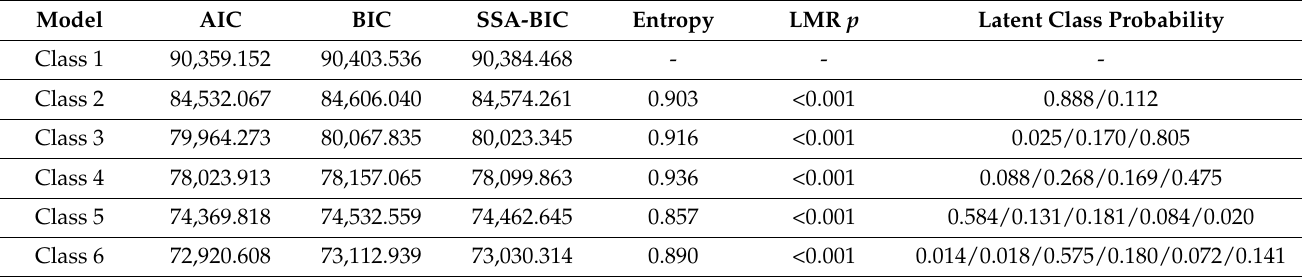
Table 1. Comparison of the fit index of different latent class